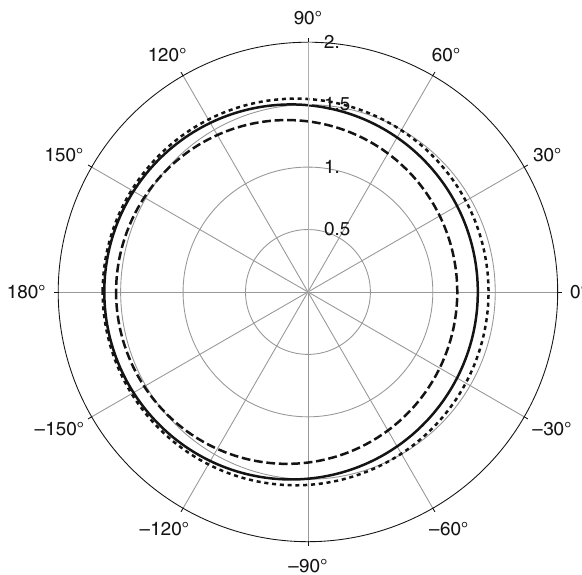
Fig. 3 Dependence of d 2 σ/ d φ e d y on φ e for the standard V–A interac- tion, E ν = 1 MeV : y = 0 . 1 (dotted line), y = 0 . 2 (solid line), y = 0 . 5 (dashed line)